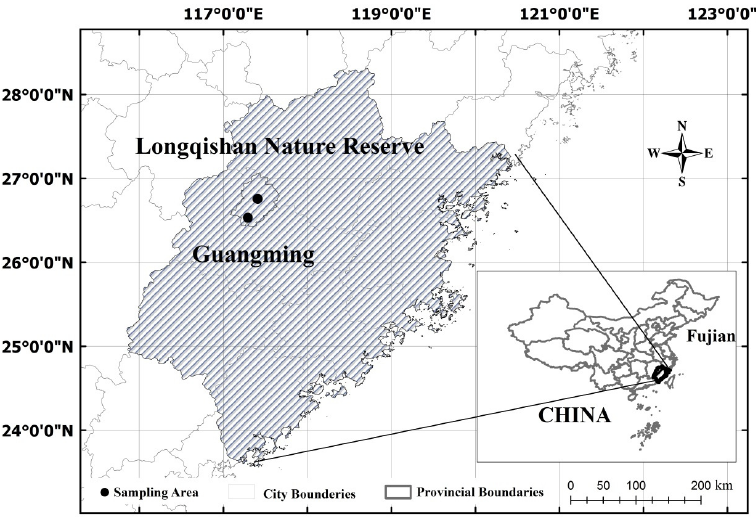
Figure 1. Location of study area and sampling sites.